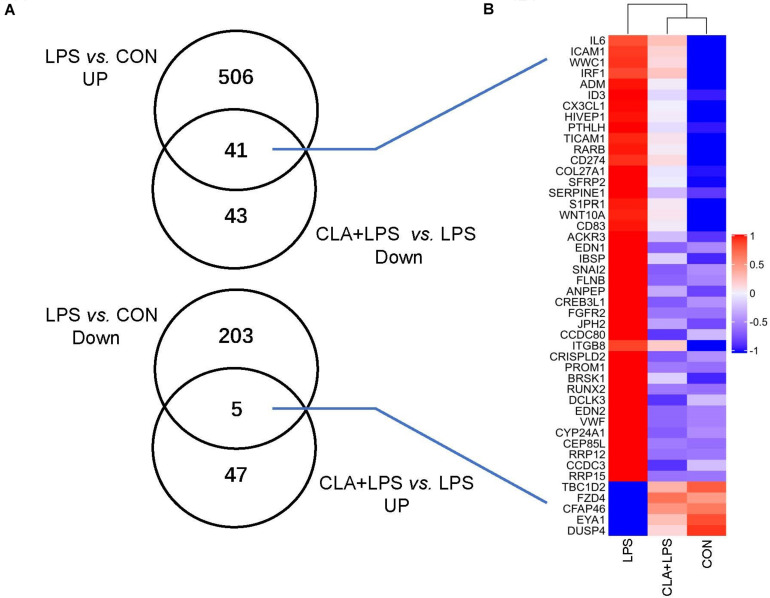
Overview of the differentially expressed genes (DEGs) after different treatments. (A) Venn diagrams of known DEGs based on comparisons of different groups. Cut-off for the differential expression criteria were Padj < 0.01 and FC > 1.5. (B) Hierarchical clustering of the overlapping DEGs among different groups. The color code indicates highly expressed genes (red) and genes expressed at low levels (blue).